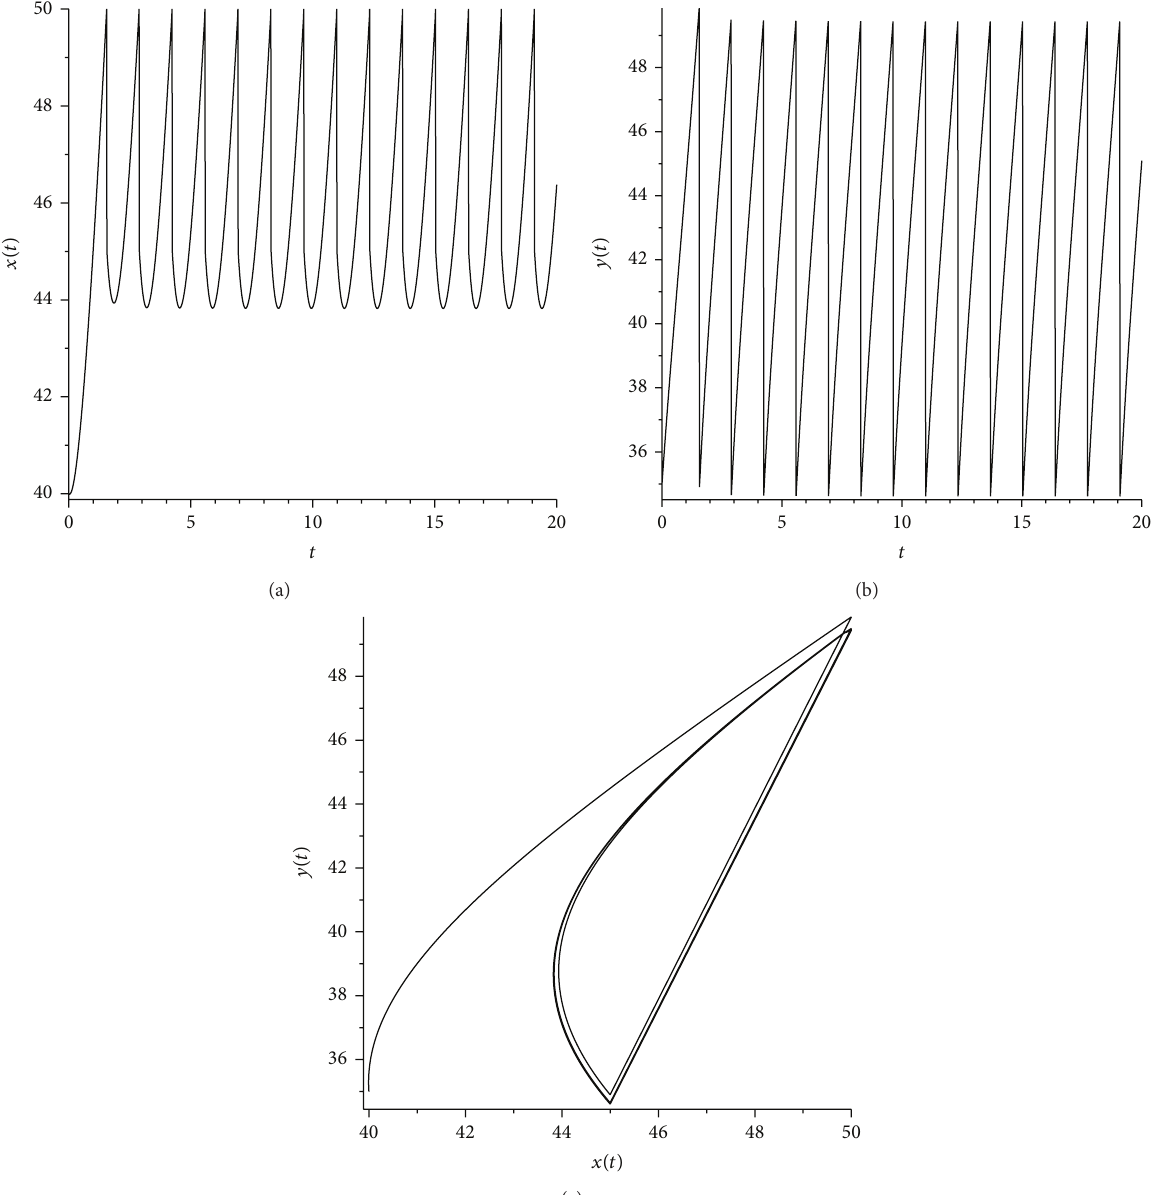
Figure 12: Time series and phase portrait of system (1) with 𝑎 = 1 . 7 , 𝑏 = 1 . 5 , 𝑐 = 0 . 8 , 𝑑 = 0 . 6 , 𝑥 ∗ = 50 ,𝛼 = 0 . 1 , 𝛽 = 0 . 3 , (𝑥 0 , 𝑦 0 ) = ( 40 , 35 ) .